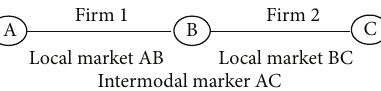
Figure 1: An intermodal market